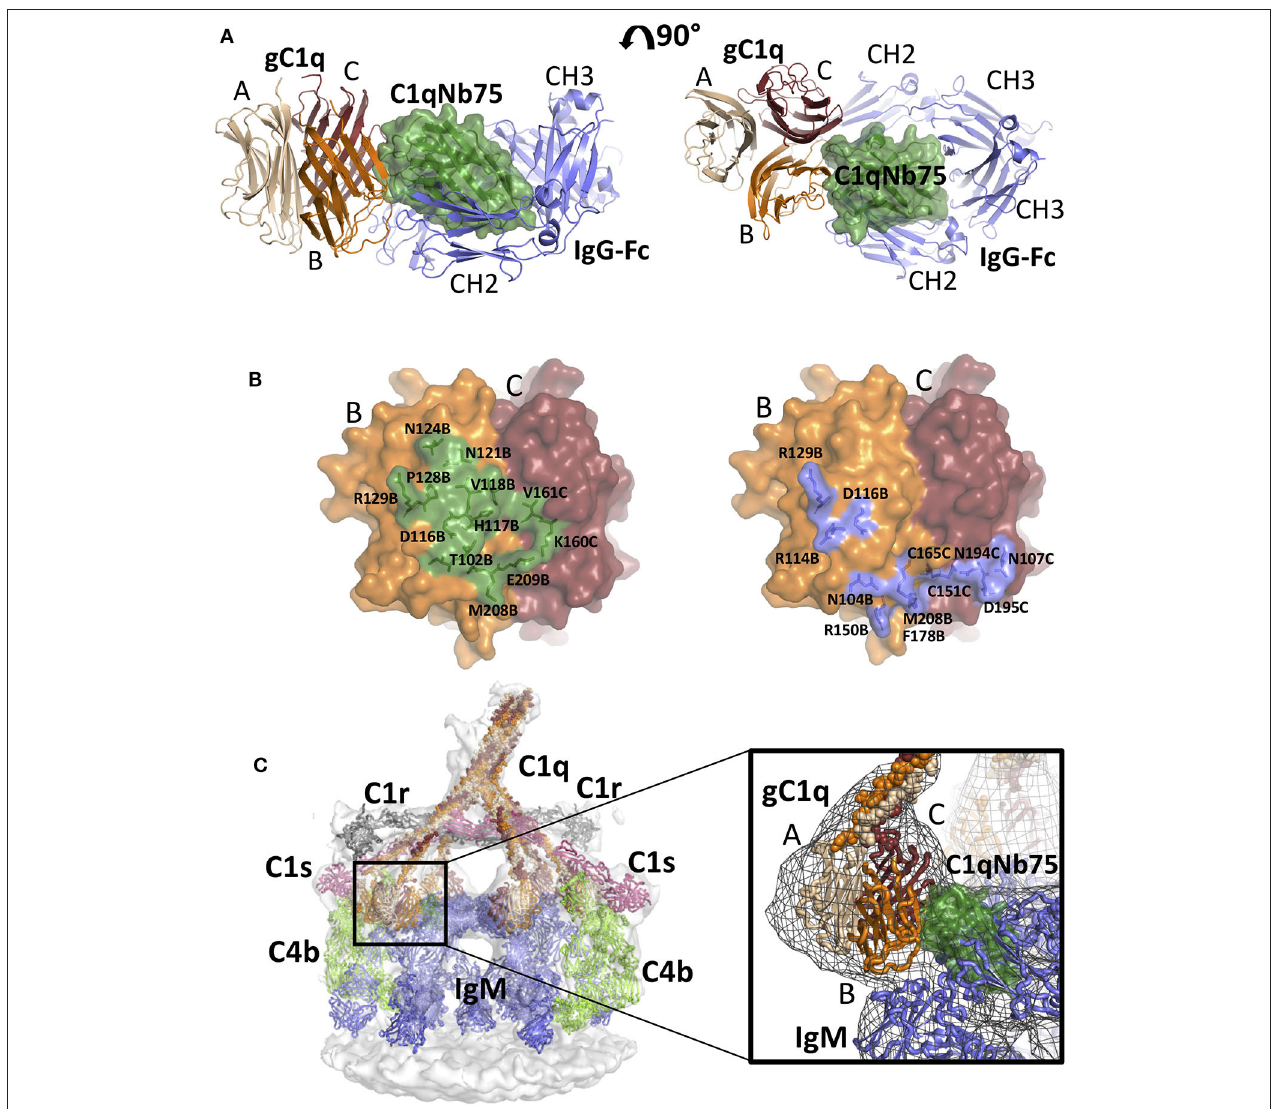
FIGURE 5 | Comparison of the gC1q-C1qNb75 complex with models of IgG Fc-gC1q and C1-IgM-C4b explains the inhibition of the CP. (A) Alignment of the crystal structure of the gC1q-C1qNb75 complex with the cryo-EM structure of IgG Fc in complex with gC1q (PDBID: 6FCZ). The gC1q-C1qNb75 is colored as in Figure 4 and IgG-Fc is shown in blue. Similar to Figure 4A , side view (left) and top view (right) are shown. A massive clash between C1qNb75 and IgG Fc is observed. (B) The C1qNb75 epitope overlaps with gC1q residues involved in IgG contacts. Left: epitope of C1qNb75 on gC1q with residues involved in the interaction shown as sticks and in green. Right: gC1q residues involved in the interaction with IgG-Fc are shown in sticks and colored blue. (C) Model of the C1-IgM-C4b complex and comparison with the structure of gC1q-C1qNb75. Left: Overview of the entire C1-IgM-C4b complex, right: close up view of the steric overlap of C1qNb75 with IgM Fc. The C4b is colored light green, C1r gray, C1s purple, IgM blue, whereas C1qNb75 and C1q chains are colored as in (A) . The 3D reconstruction is displayed as a transparent surface in the overview (left) and as a mesh in the close-up